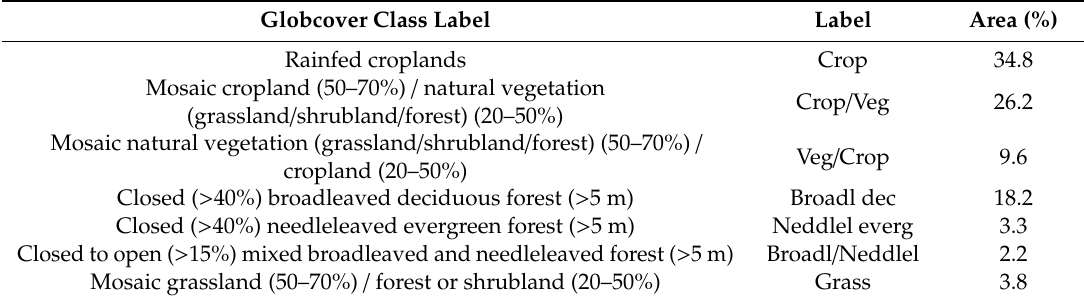
Table 1. Original land cover class labels, land cover labels used in this work, and area occupied by each land cover class, as obtained by Globcover 2009. Only cover classes covering more than 1% of the territory are